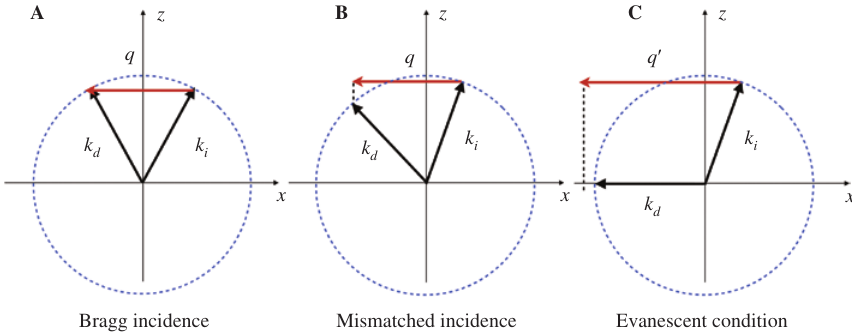
Figure 1: Typical Fourier space geometries in phase diffraction gratings. (A) Bragg incidence, (B) Bragg-mismatched incidence, and (C) evanescent (nonradiative) condition of a diffracted